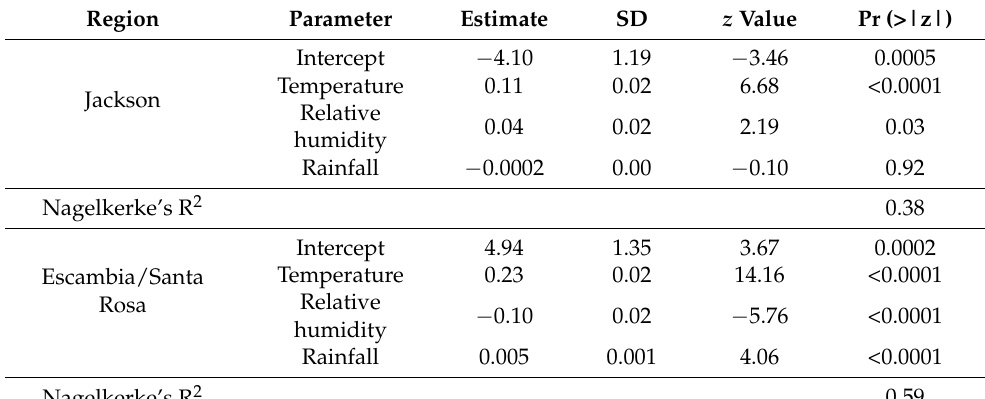
Table 2. Weather variables association with H. zea moth catch in Jackson and Santa Rosa/Escambia, Florida, from June 2017 to June 2019.